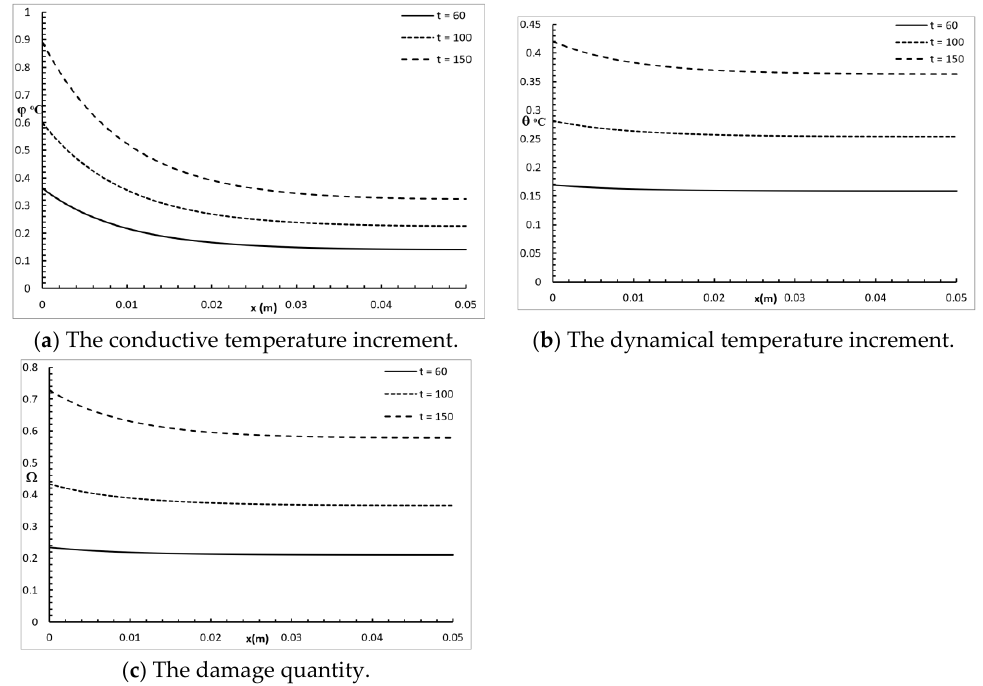
Figure 6. The studied functions for various values of the time t.